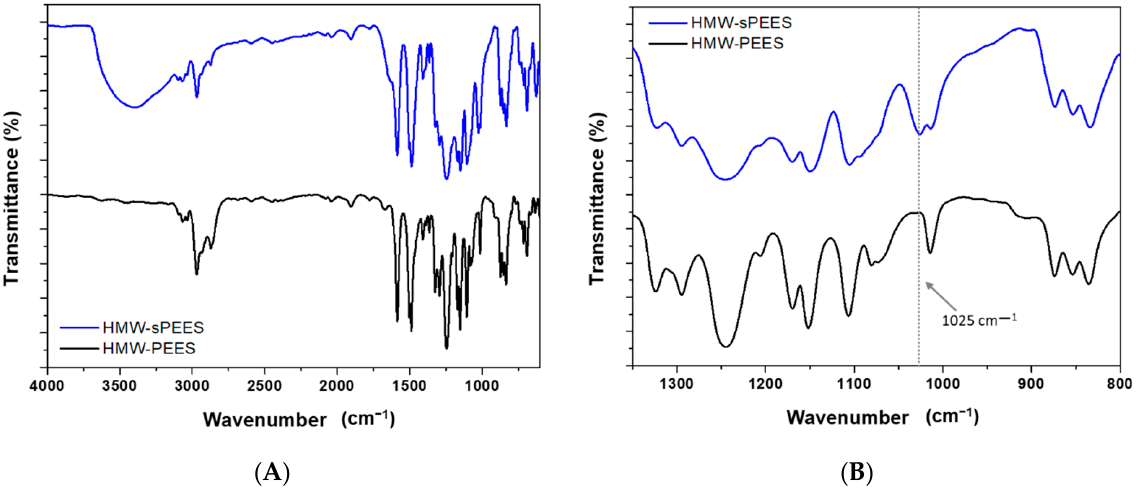
Figure 3. ( A ) Infrared spectrum of the polymer before (HMW-PEES) and after (HMW-sPEES) sul- fonation; ( B ) broadening of the infrared spectrum in the region from 1350 cm − 1 to 800 cm − 1 . For the sulfonated PEES samples, the infrared spectrum, in general, does not show a clear presence of the characteristic bands of the sulfonic acid groups because the sulfone groups (O=S=O) of the main chain of the polymer overlap with the specific signals of the sulfonic acid groups. However, it is observed in Figure 3B that the presence of a shoulder around 1025 cm − 1 is associated with the extension of -SO 3 of the sulfonic group [62], which shows the incorporation of these groups in the polymer structure. However, confirmation of the PEES modification was performed by 1 H NMR (Figure 4). The sulfonated poly(ether ether sulfone) presents a characteristic signal at 7.72 ppm corresponding to the proton adjacent to the sulfonic group (2 ″ in Figure 4) [63], which confirms the insertion of the sulfonic acid groups in the structure of the polymer.